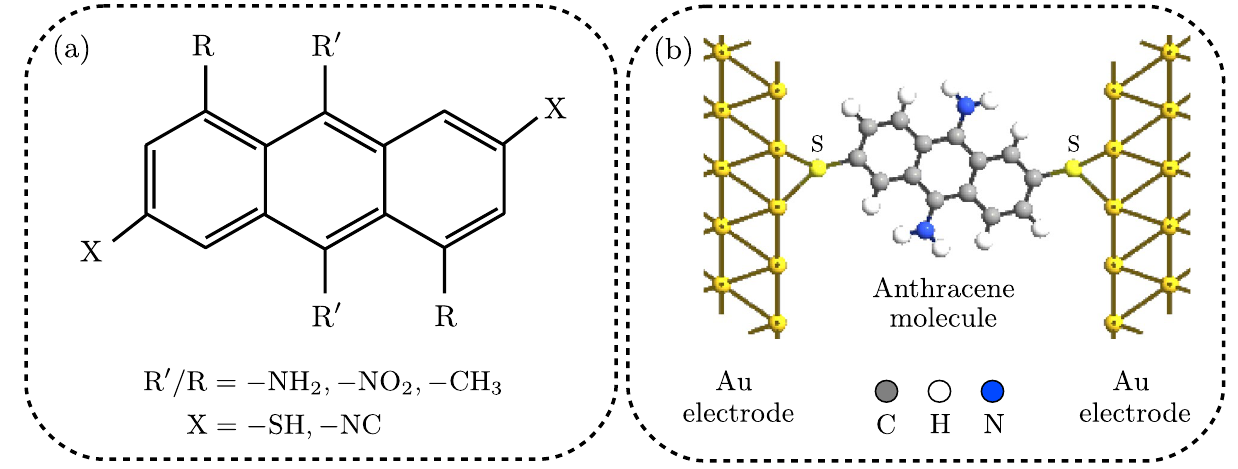
Figure 1. ( a ) Schematic representation of side groups in the R ′ and R positions and anchoring groups in the X position attached to an anthracene molecule: R ′ / R = amine ( − NH 2 ), nitro ( − NO 2 ) or methyl ( − CH 3 ), and X = thiol ( − SH ) or isocyanide ( − NC ). ( b ) The examplary device model of the anthracene molecule with amine as the side group in the R ′ position when the molecule is coupled to the hollow position of the tips of two Au (111) pyramids via the thiol anchoring